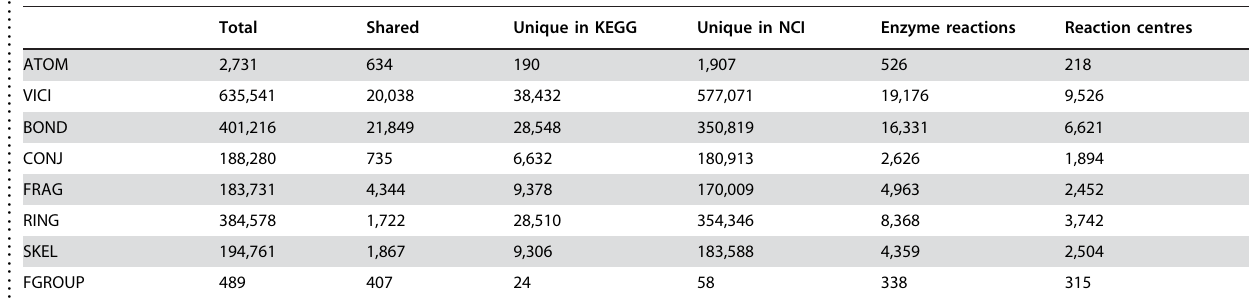
Table 2. Statistics on SUBSTRUCTURE and FGROUP entries in BiSSCat. .. ... ....